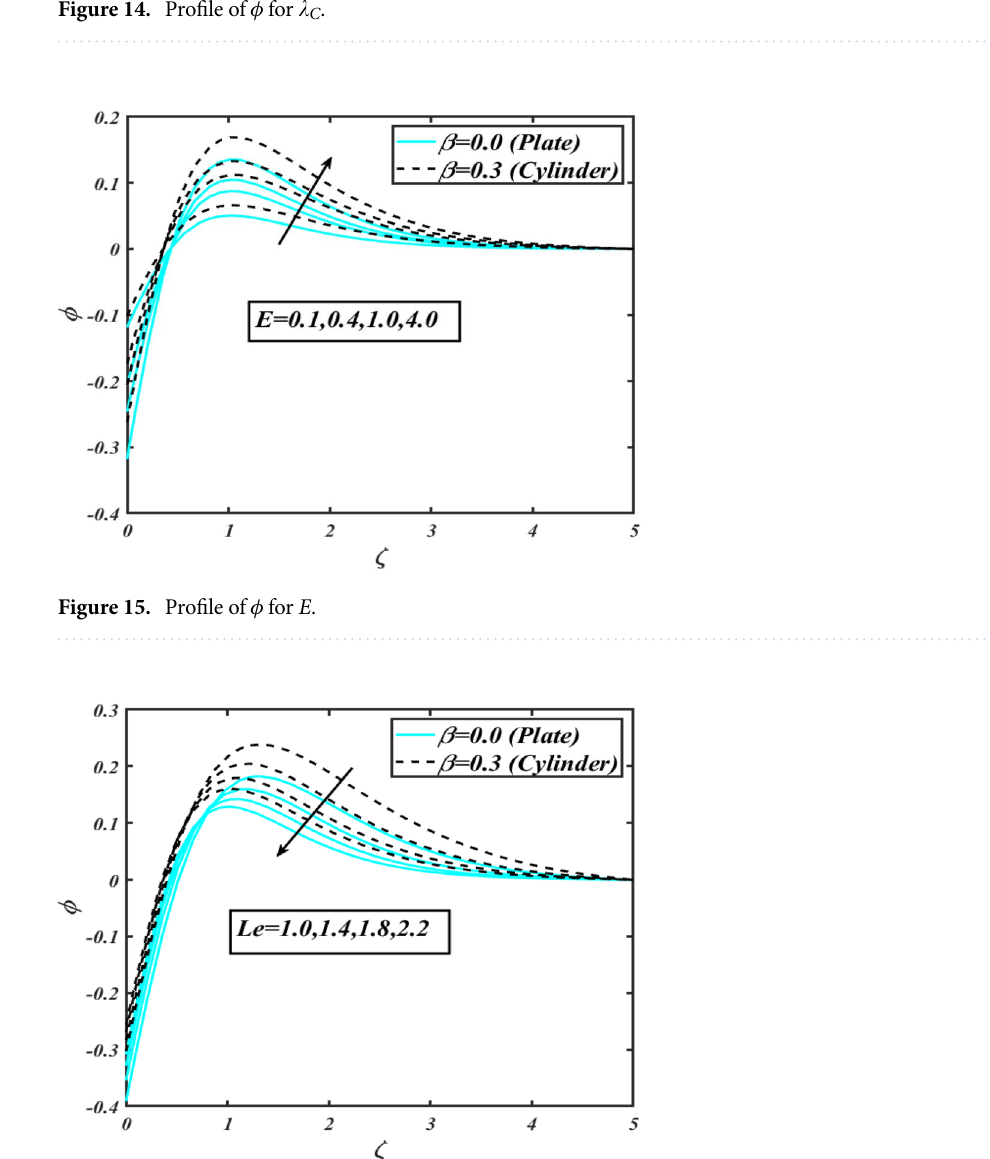
Figure 14. Profile of φ for (cid:31) C .